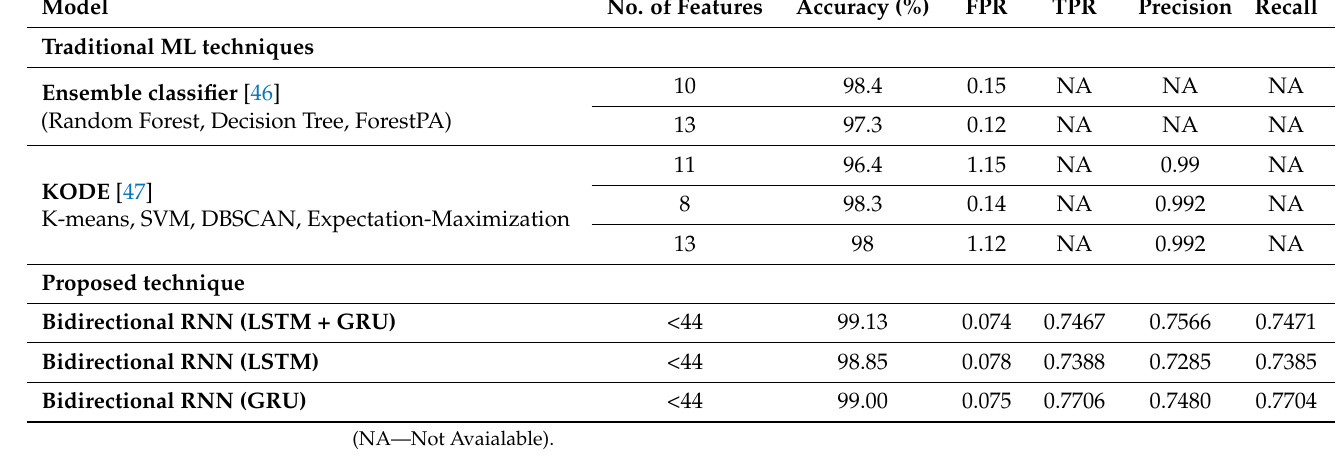
Table 12. Performance of models.